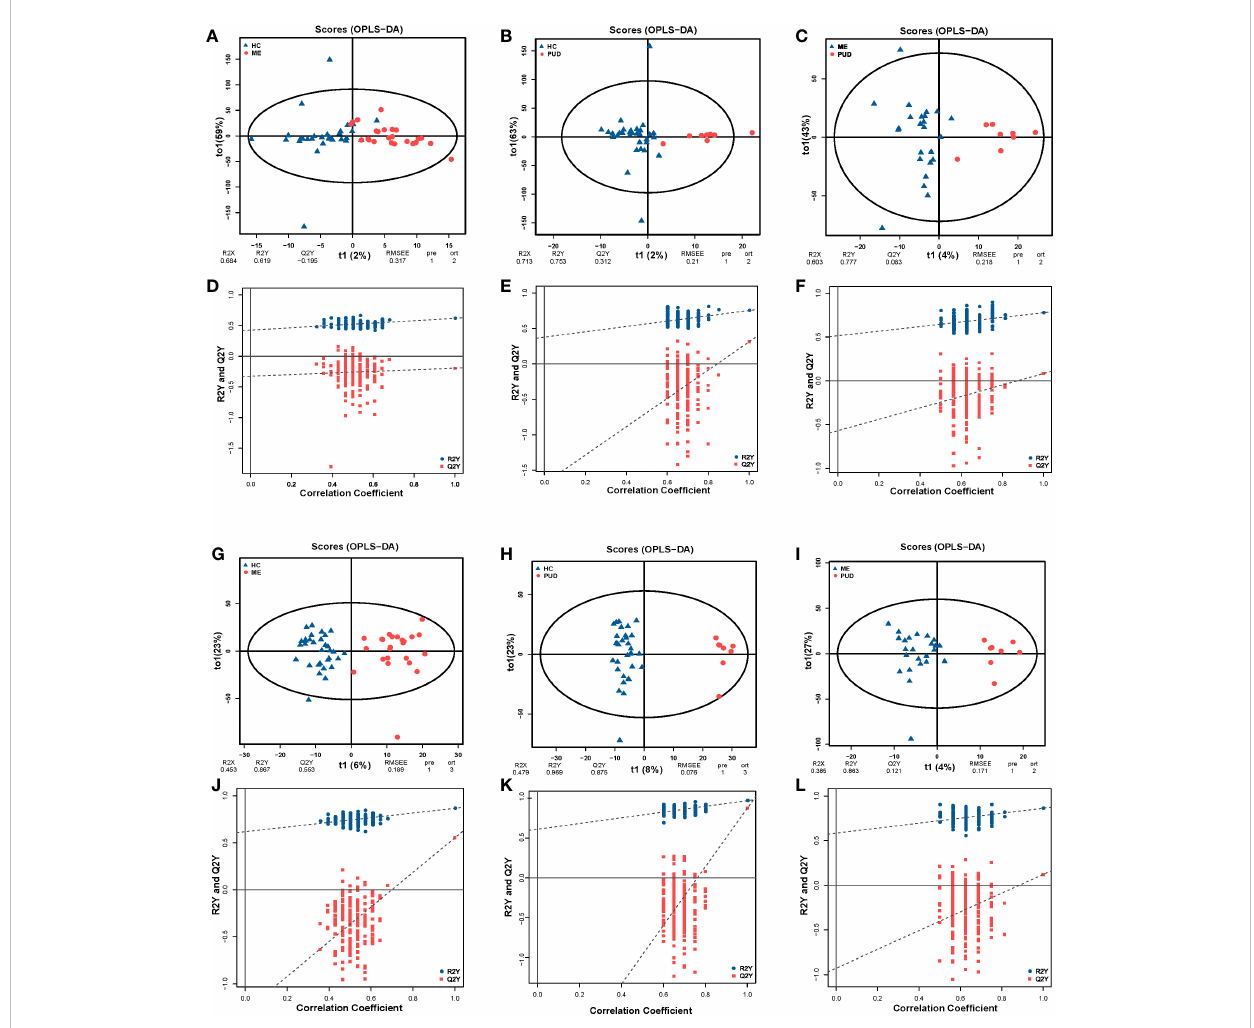
FIGURE 5 OPLS-DA and permutation test. (A, G) , the OPLS-DA model of HC vs. ME; (A) , the positive ion mode; (G) , the negative ion mode; (D, J) , the permutation test models of (A, G) . (B, H) , the OPLS-DA model of HC vs. PUD; (B) , the positive ion mode; (H) , the negative ion mode; (E, K) , the permutation test models of (B, H) . (C, I) , the OPLS-DA model of ME vs. PUD; (C) the positive ion mode; (I) , the negative ion mode; (F, L) , the permutation test models of (C, I) . The times of permutation tests is